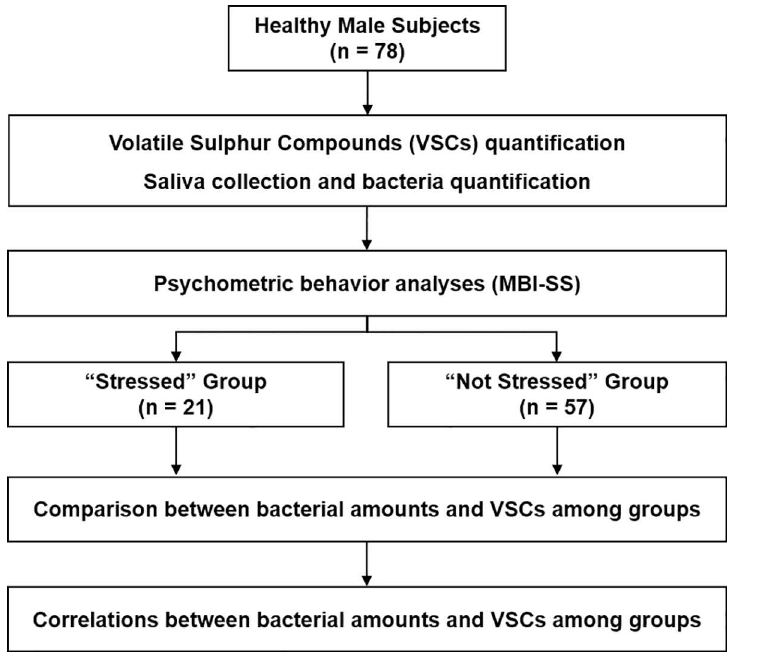
Fig 1. Flowchart of experimental